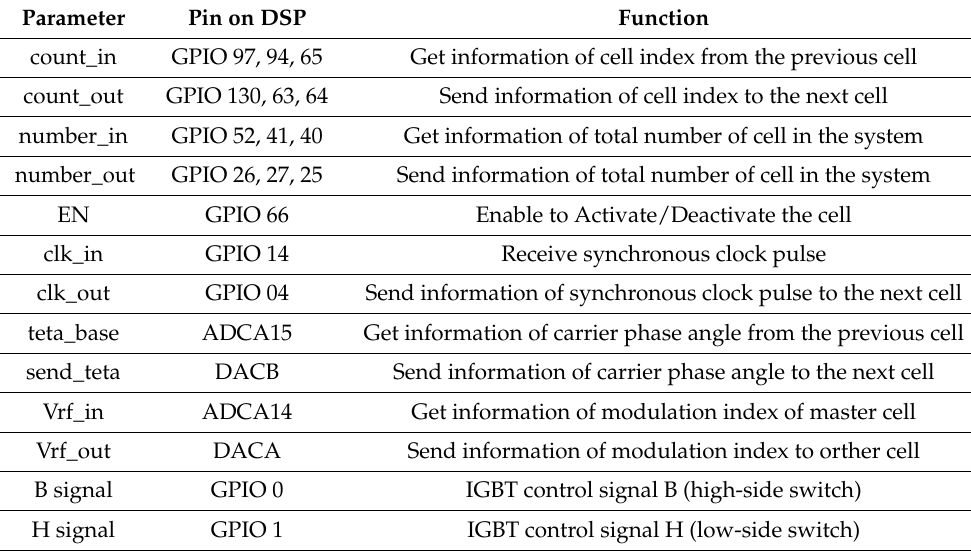
Figure 30. System diagram for the experimentation of the DSA-PSC method. Table 8. Function of control pins of digital signal processor (DSP) for algorithm DSA-PSC.